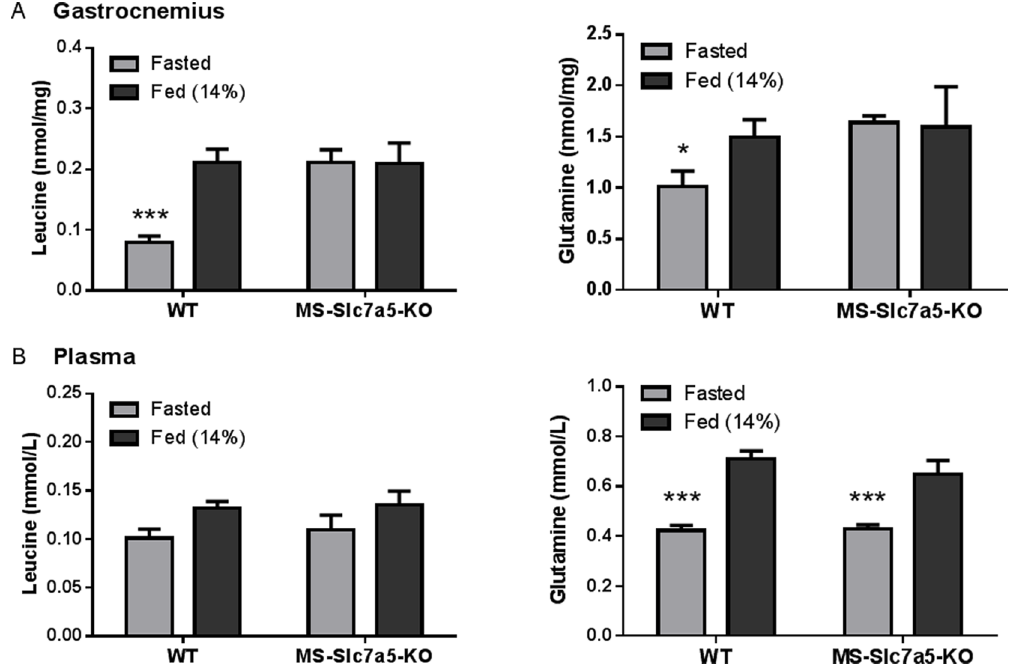
Figure 4. Effect of 8 h overnight fast on muscle and plasma amino acid (leucine, glutamine) concentrations in MS- Slc7a5 -KO mice. Mean 6 SEM for n=6–9 (WT) and 3–5 (MS- Slc7a5 -KO) mice. (A) Intramuscular AA are significantly lower after 8 h fast in WT animals but not MS- Slc7a5 -KO animals. *and ***indicate p , 0.05 and p , 0.001 respectively by Bonferroni’s post t- test). (B) Plasma glutamine concentrations are significantly lower after 8 h fast for both genotypes (***indicates p , 0.001 by Bonferroni’s post t- test), although an overall effect of fasting on plasma leucine is detected ( F (1, 19)=5.49, p =.030), the difference does not achieve p , 0.05 for either genotype.